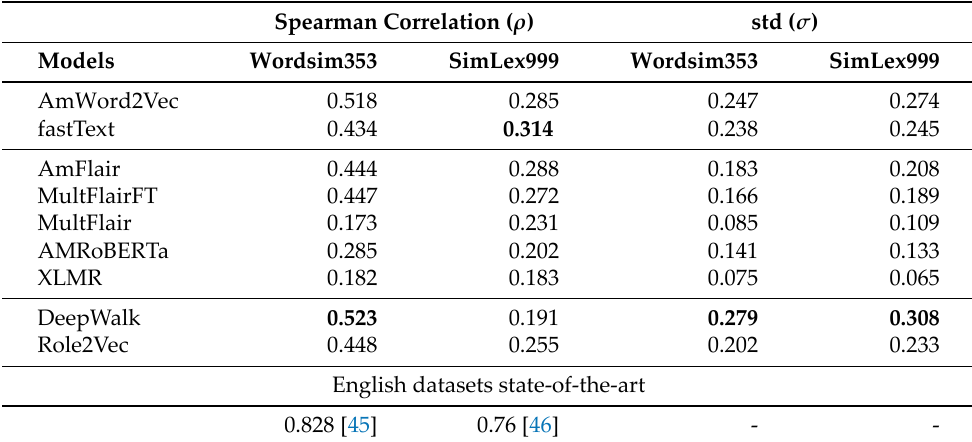
Table 5. Spearman correlation ( ρ ) and standard deviation ( σ ) scores on the Amharic Wordsim353 and SimLex999